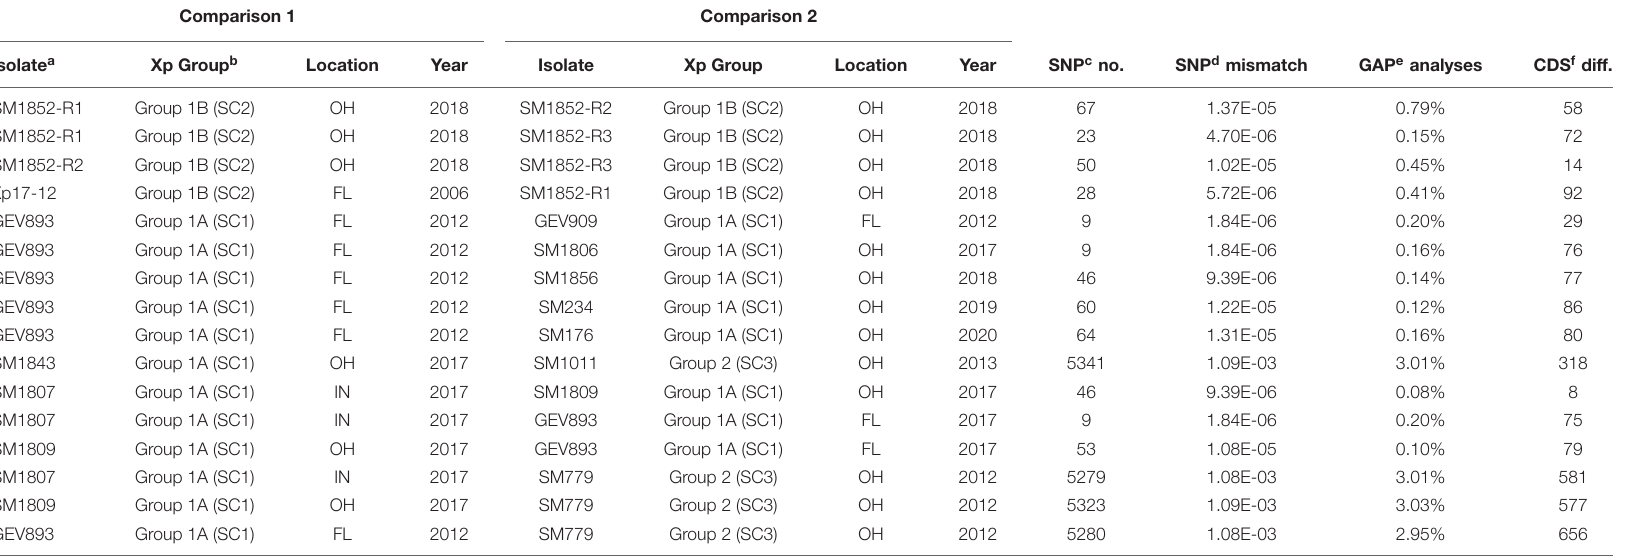
a Isolate names are referenced in Supplementary Table 1 . SM1852-R1 is a single colony isolate sequenced on the first run, SM1852-R2 and SM1852-R3 are from the same DNA source using separate sets of adapters during library preparation prior to sequencing.